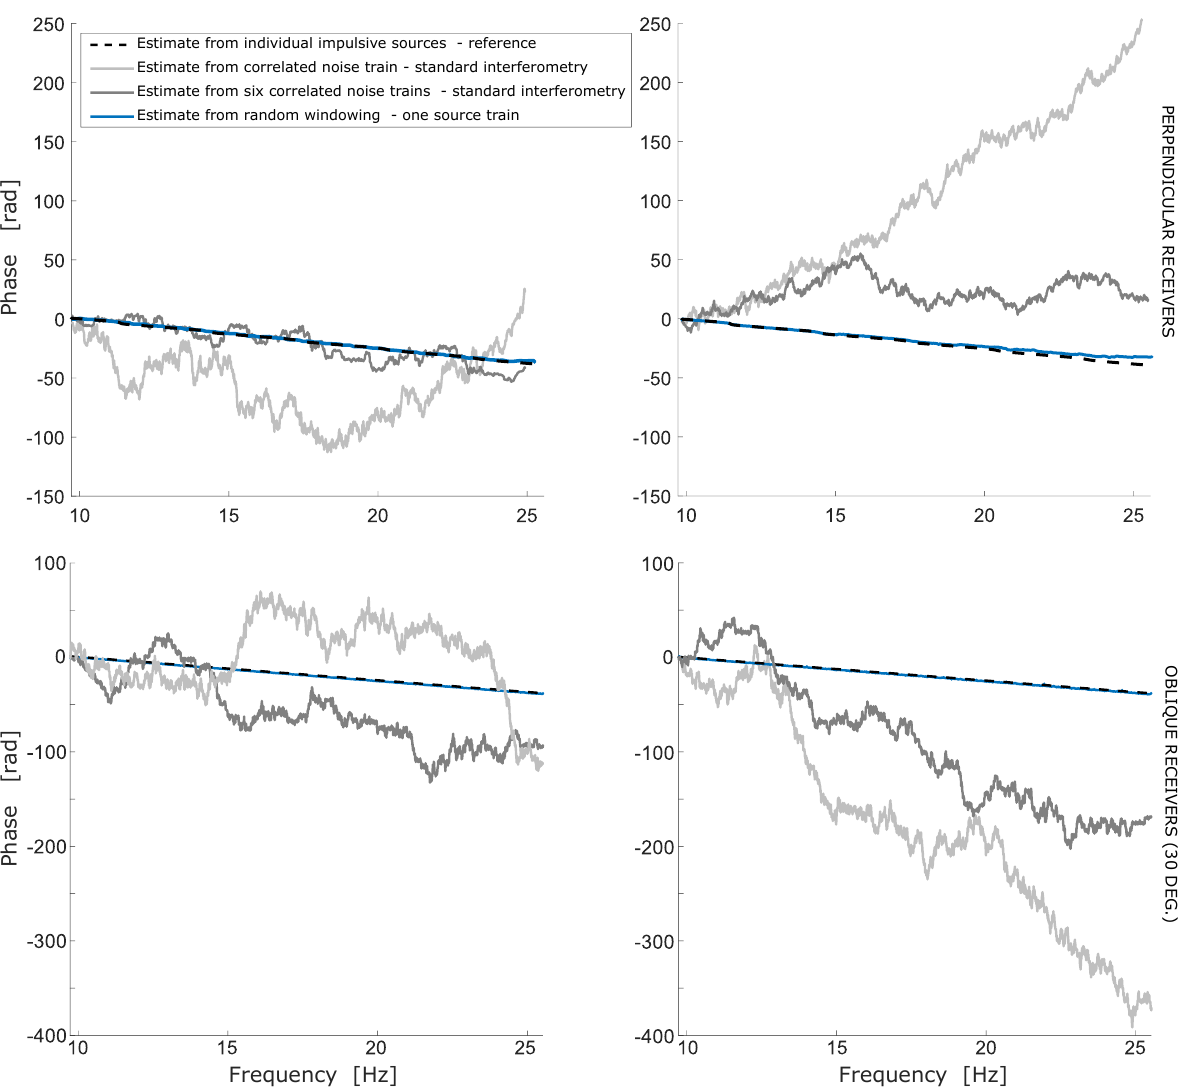
Figure 10. Phase estimates obtained from the random windowing scheme applied to a short (5 min) recording of a single source using receivers that are perpendicularly oriented with respect to the source-line ( top ) and oriented at 30 degrees with respect to the source-line ( bottom ). The left column shows the results for correlated noise where source phases at different frequencies are independent (as in Figure 4). The phase estimated from discrete sources, in black dashes, is used for reference. The phases produced by the random windowing scheme are shown in blue and exhibit very good agreement with the reference phase. The phase of the retrieval using the standard method and no stacking is shown in light gray, and the phase of six stacked sources is shown in dark gray for comparison. The same phase estimates are shown in the right column for correlated noise with correlated source phases (as shown in Figure 6). The phase estimates from the random windowing scheme, in blue, are better than the retrieval obtained using the standard method, with slightly reduced accuracy at higher